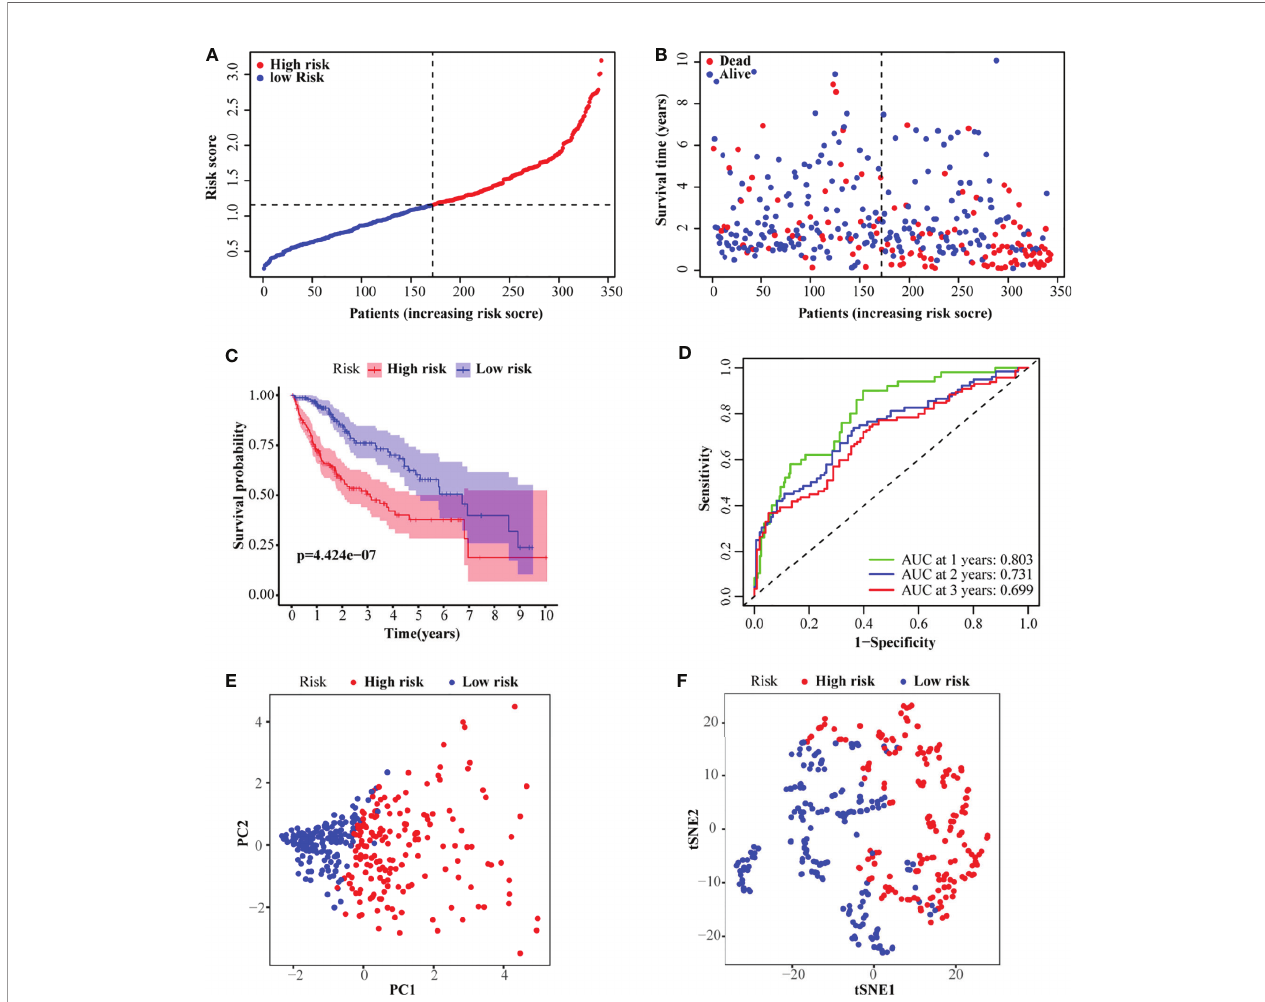
FIGURE 2 | Prognostic analysis of the six-gene signature in the TCGA set. (A, B) The distribution and median value of the risk scores in the TCGA set. (C) Kaplan – Meier curves for the OS of patients in the high-risk group and low-risk group. (D) AUC of time-dependent ROC curves in the TCGA set. (E) PCA and (F) t-SNE analysis of the ICGC